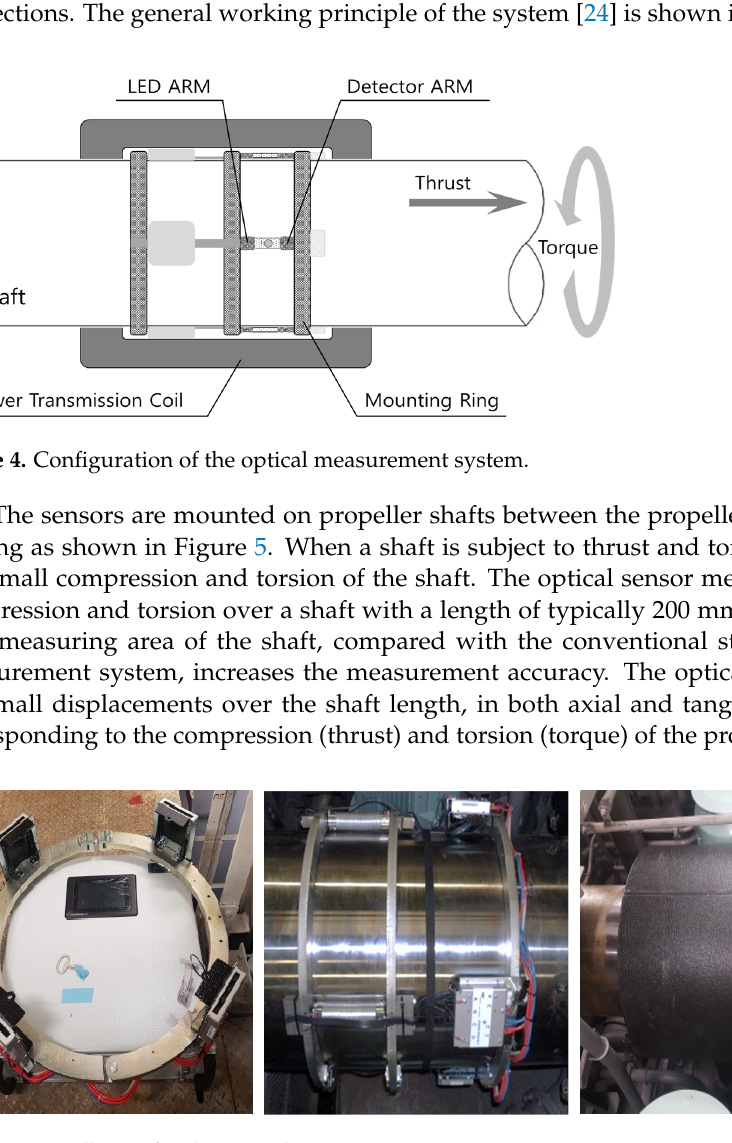
Figure 5. Installation for the optical measurement system.